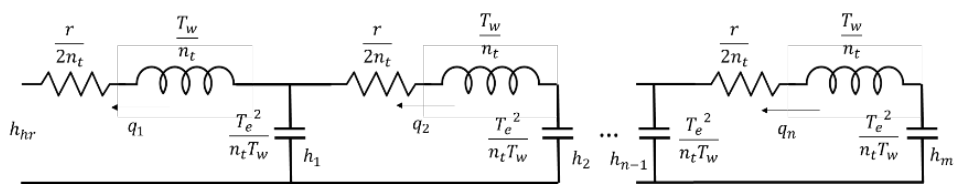
Figure 3. Scheme of the penstock model.